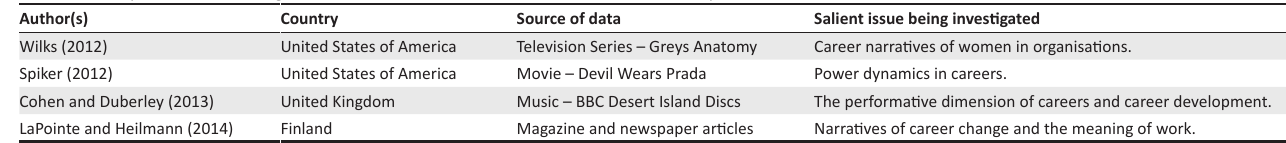
TABLE 1: Examples of studies using media sources to understand careers and career development.